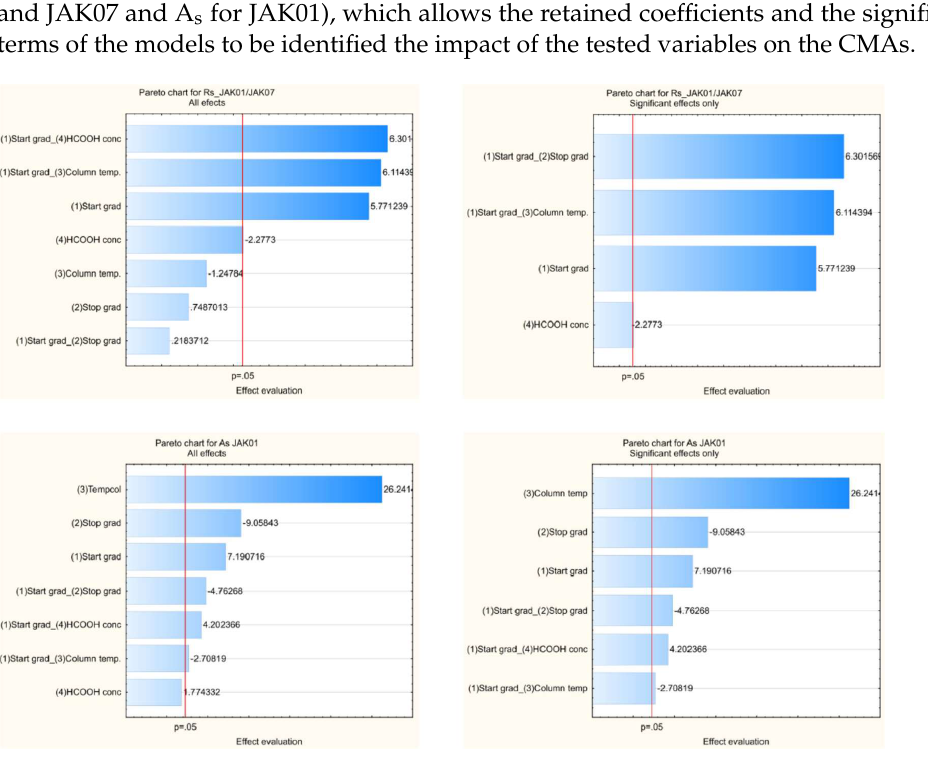
Figure 8. The Pareto chart for Rs between JAK01 and JAK07 and As for JAK01 for robustness